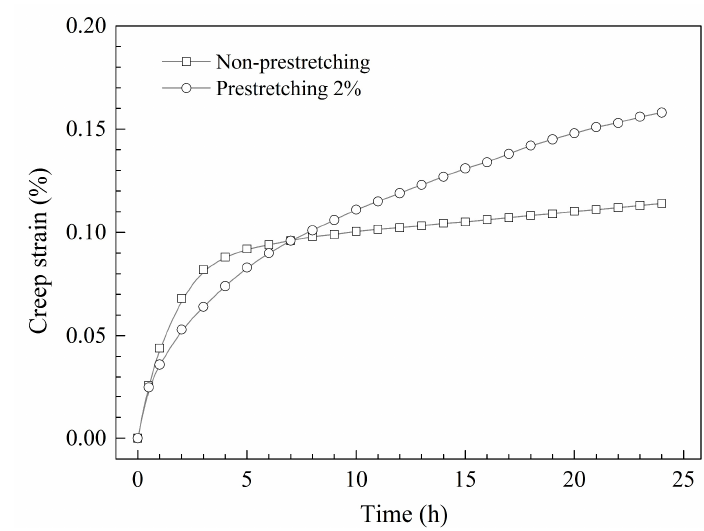
Figure 2. Creep strain curves of AA2195 specimens with different pre-stretched states under the same stress (200 MPa) and temperature (170 °C).